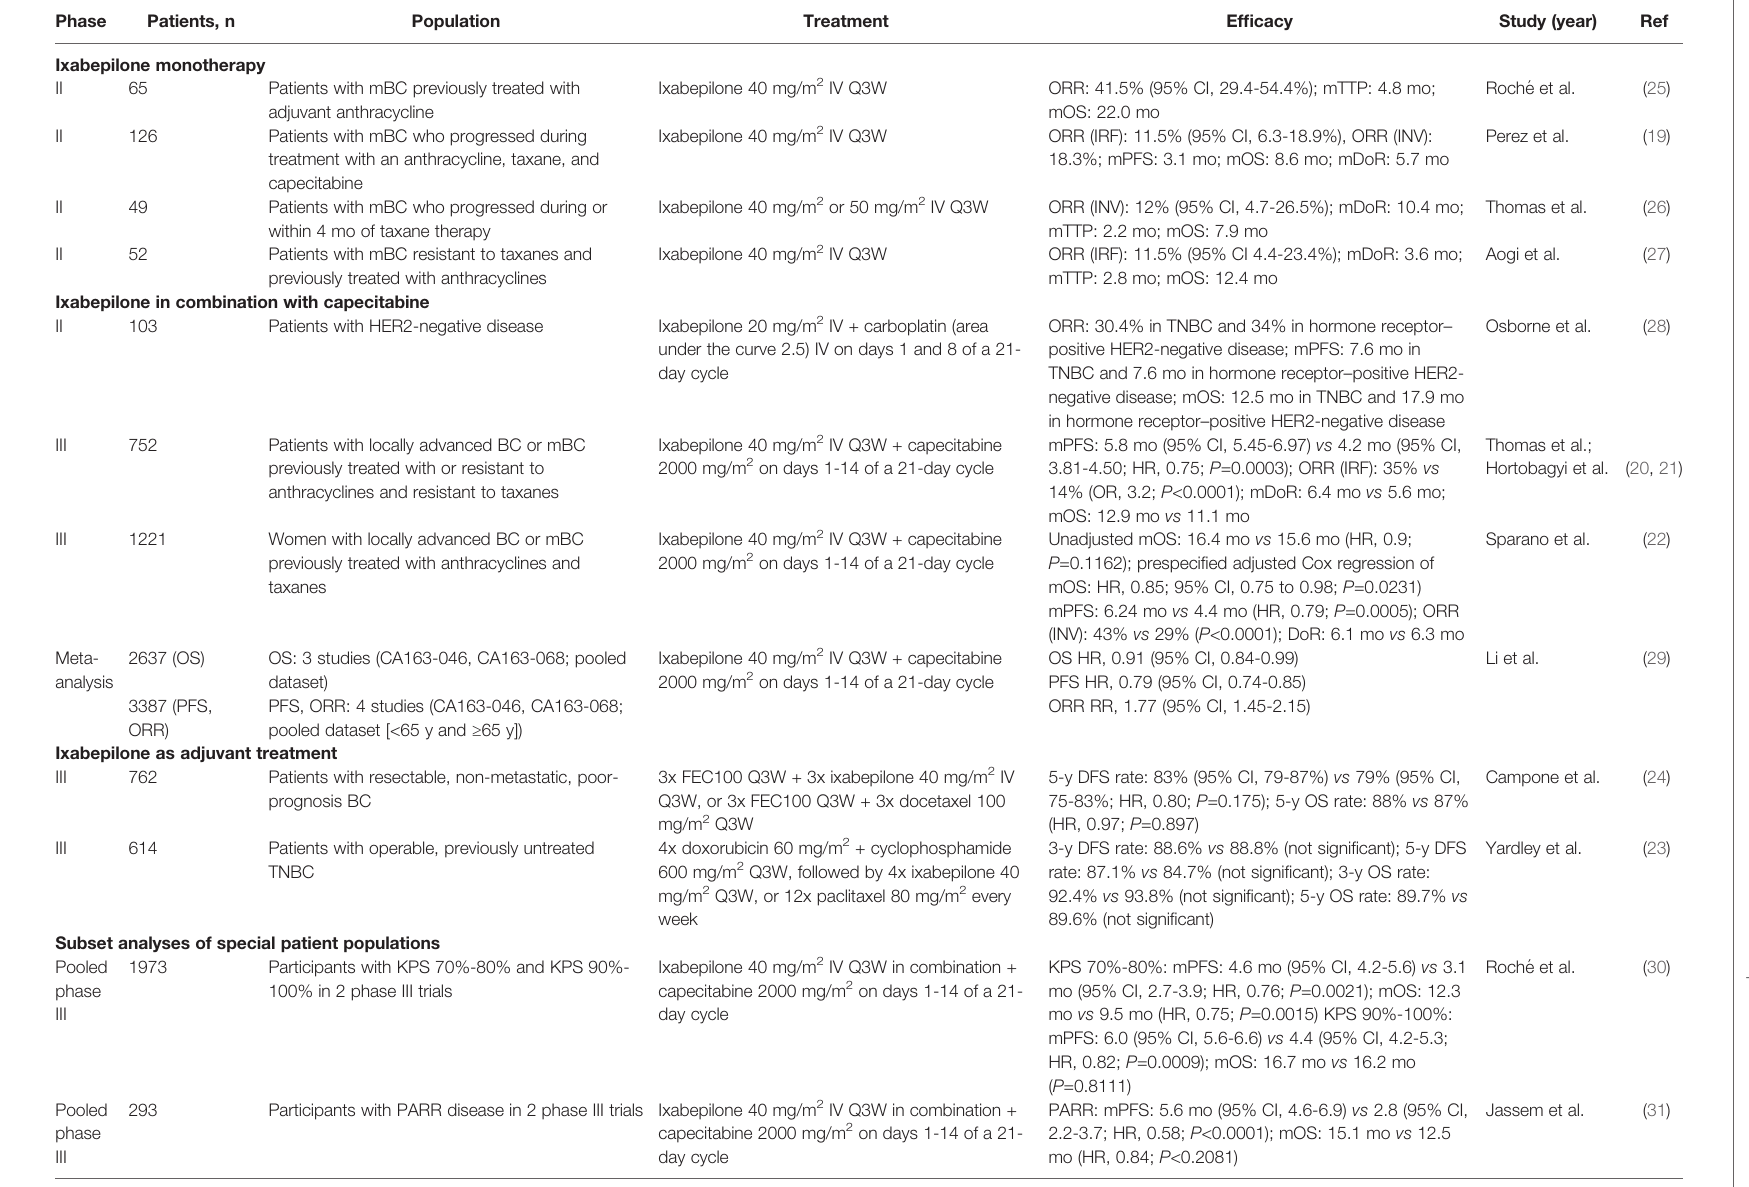
TABLE 2 | Summary of key ef fi cacy measures across the clinical studies with ixabepilone in breast cancer.